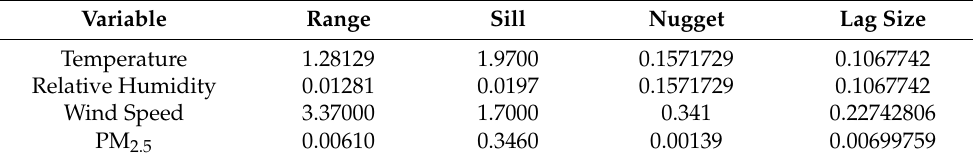
Table 4. Variogram model parameter deviations of the main studied